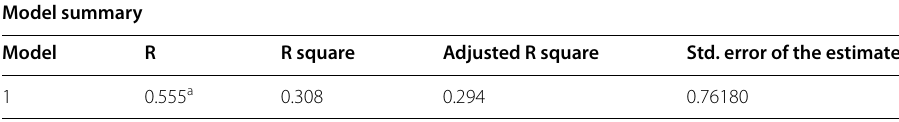
Table 9 Multiple regression analysis for the public school students